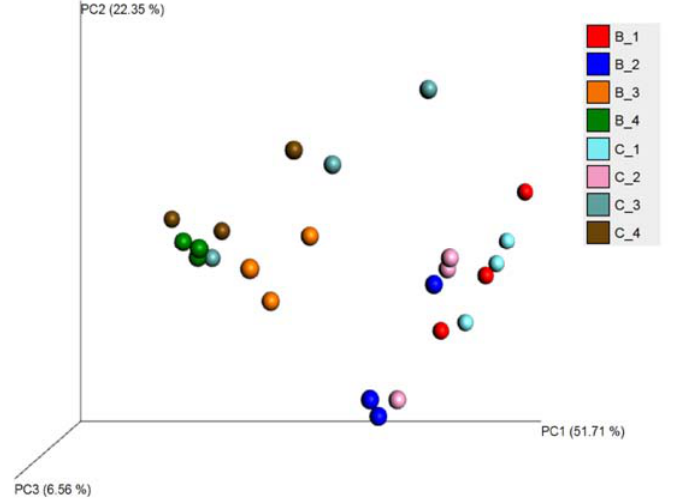
Figure 8. Principal coordinate analysis (PCoA) showing the diversity among all samples. In the legend, B represents biochanin A samples, C represents the control group, and the digital represent the culture generation.